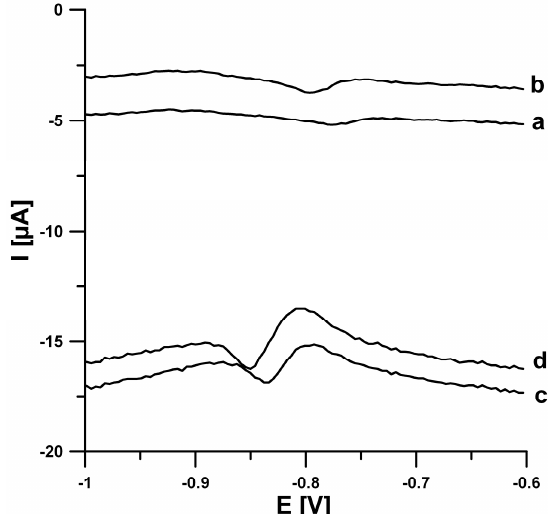
Figure 2. Square-wave voltammograms of 5.0 × 10 − 7 mol L − 1 (a and c) and 1.0 × 10 − 6 mol L − 1 (b and d) EIMTC in 0.1 mol L − 1 acetate buffer solution of pH 4.5 at the screen-printed carbon sensor (SPCE) (a